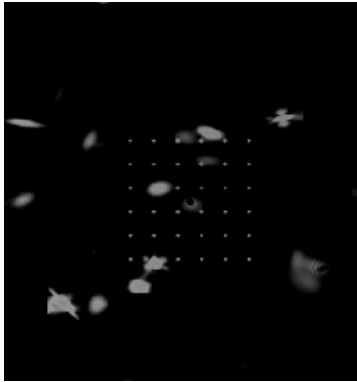
Figure 16. The simulated deteriorated